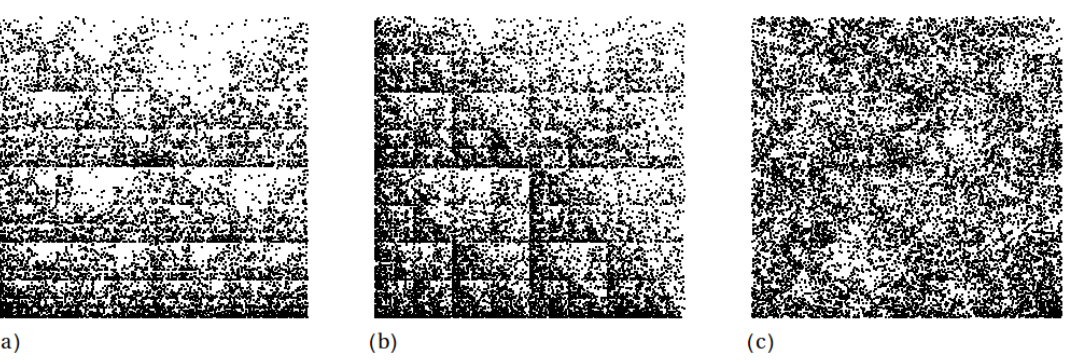
Figure 10. CGR in the “ACGT” square, with A = ( 0,0 ) , T = ( 1/2,0 ) , G = ( 1/2,1/2 ) , C = ( 0,1/2 ) for Phospholamban , GenBank ID: 5350 ( a ), Mouse mitochondrion , GenBank ID: 342520 ( b ), and Escherichia coli ( c ), NCBI Accession Version